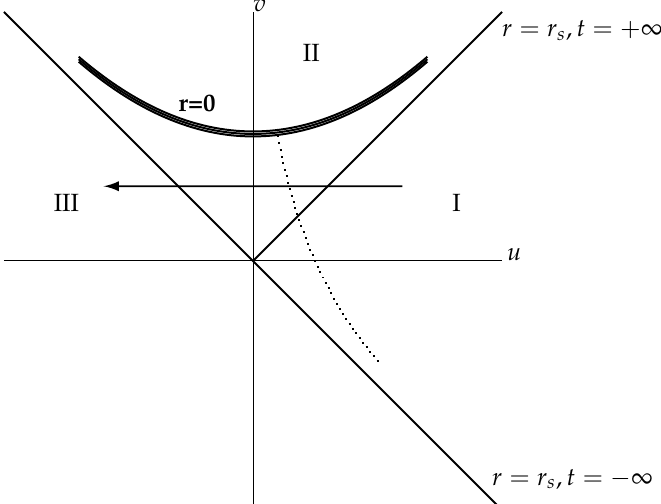
Figure 7. K-S coordinates for a black hole. The dotted line is the trajectory of an ordinary particle that crosses the event horizon and is consumed at the center. The arrow line shows a possible transit of a tachyon through the black